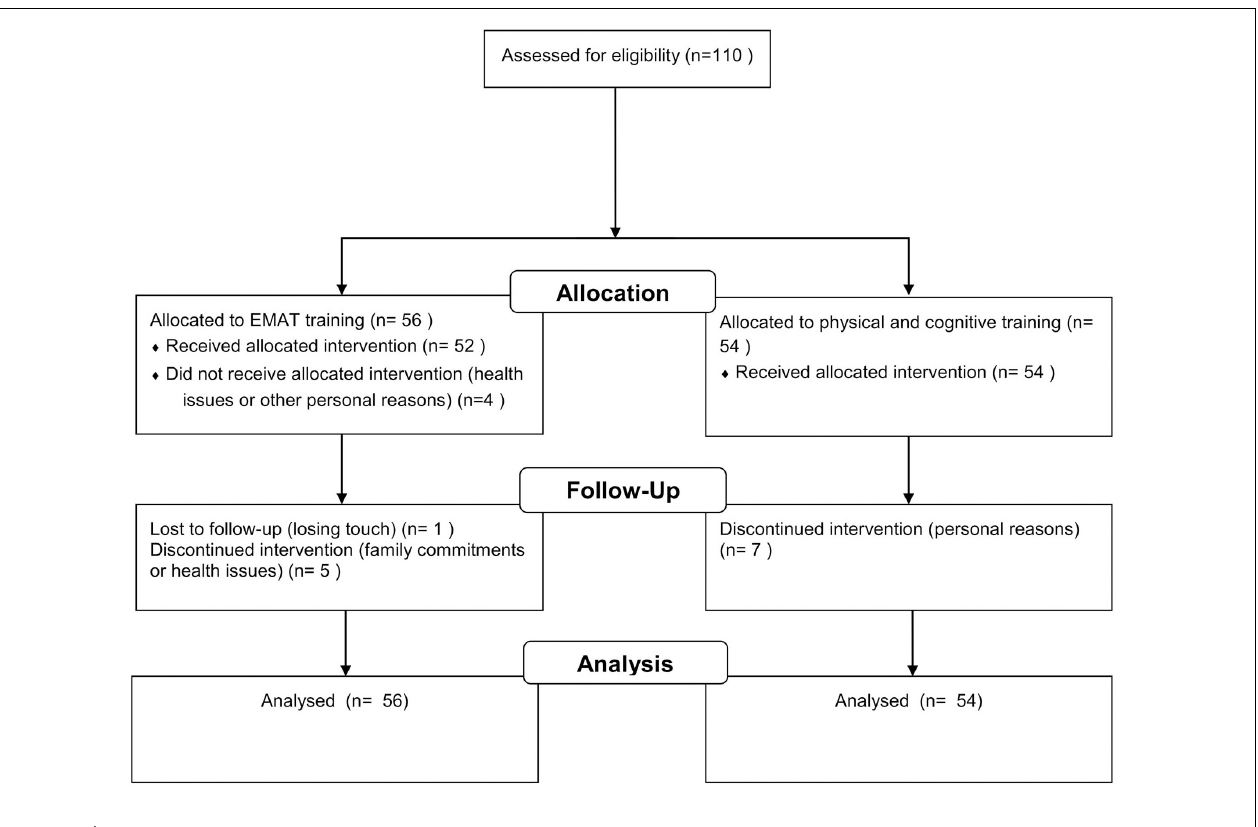
FIGURE 2 | Flowchart of the present study. TABLE 3 | Pre- and post-intervention changes in physical performance, cognitive function, dual-task walking, and fall risk in the exercise versus control group. Exercise group (EMAT exercise) ( n = 56) Control group (conventional exercise) ( n = 54) Pre-intervention